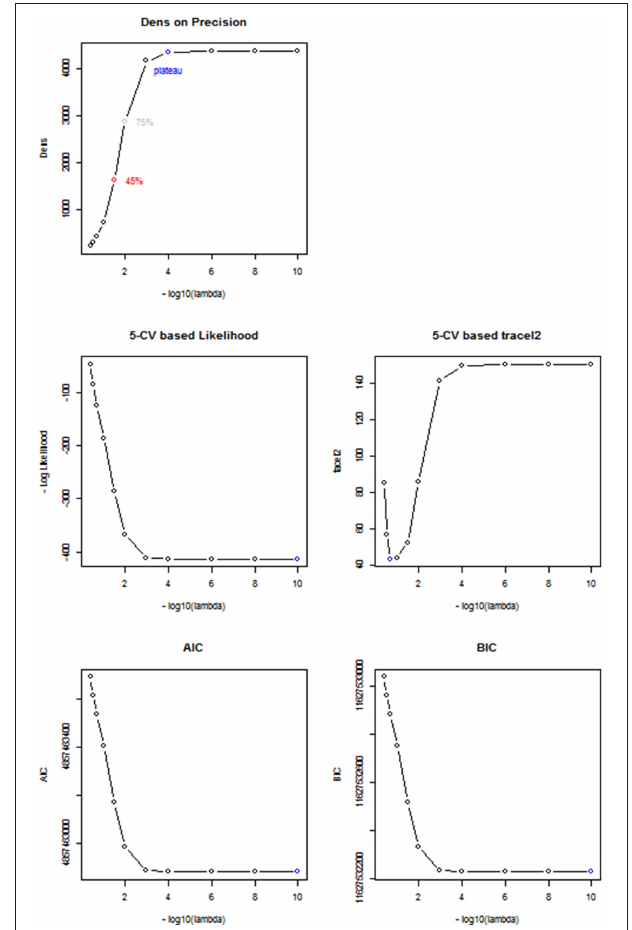
FIGURE 4 | Comparison between different Regularization methods. Based on a randomly selected subject, we compared the performance between 5 different regularization methods including Dens method, 5-CV based negative log likelihood, 5-CV based TraceL2, AIC, and BIC, where λ values are on the log 10 scale, ranging from 10 − 10 to 0.4. The selected λ − under each method is in